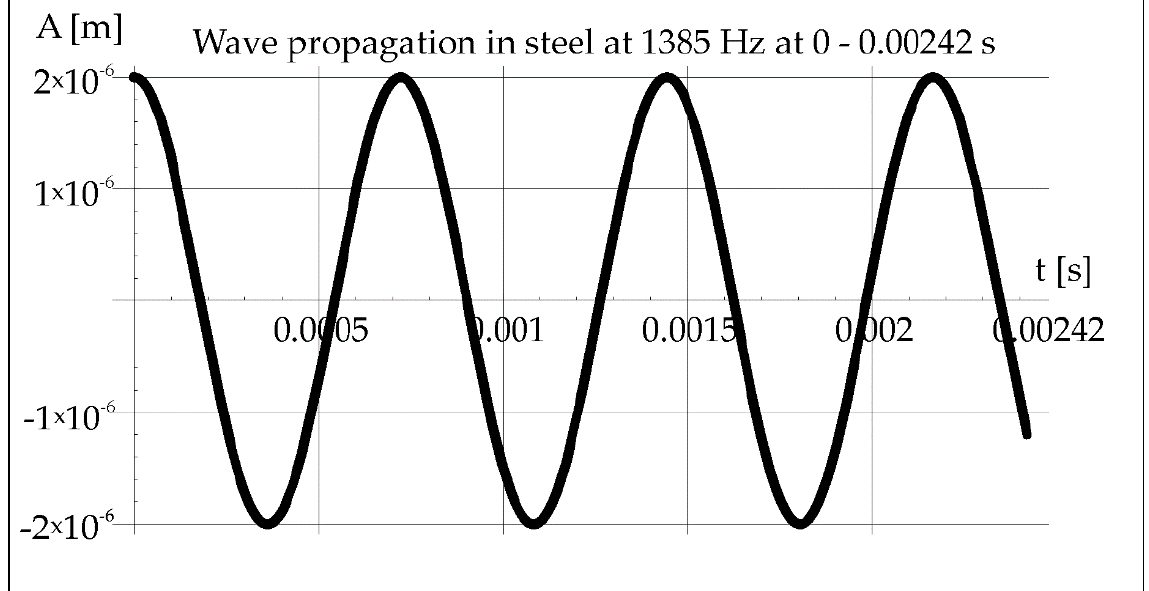
Figure 16. Propagation of acoustic wave in steel at 1385 Hz during 0–0.00242 s.